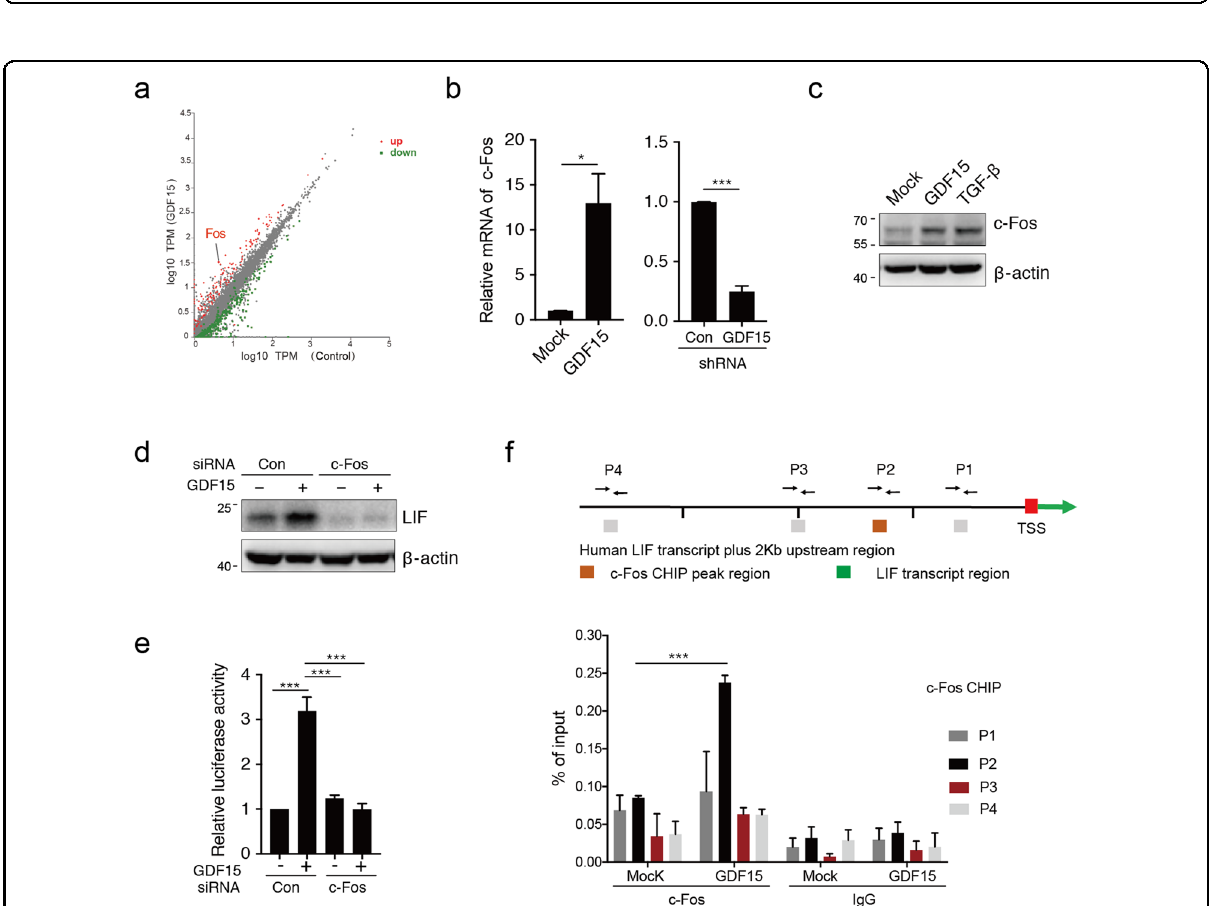
Fig. 2 GDF15 upregulates LIF transcription via c-Fos binding to the promoter. a Scatter plot showing differentially expressed genes between control and 10 ng/ml GDF15-treated U87 TS cells. b qRT-PCR analysis of c-fos gene expression in U87 TS cells treated with GDF15 or short hairpin RNA lentivirus targeting the GDF15 gene. c Immunoblotting analysis of c-Fos and β -actin expression in U87 TS cells after treatment with GDF15 and TGF- β for 5 days. d Immunoblotting analysis of LIF protein expression in U87 TS cells after treatment with GDF15 and c-Fos siRNA or control siRNA. e U87 TS cells were transfected with a luciferase construct containing the LIF promoter and treated with GDF15 and c-Fos siRNA or control siRNA for 48 h, and luciferase activity was determined using a dual-luciferase reporter assay system. f Cells were incubated without or with GDF15 and subjected to ChIP assays using c-Fos or IgG isotype control antibodies. Bar chart representing the qPCR results for the immunoprecipitated LIF promoter. Values in b , e , and f are from three independent experiments and are expressed as mean ± s.e.m. * P < 0.05, *** P < 0.0005. Unpaired t test ( b , f ); one-way ANOVA with Tukey ’ s multiple comparison test ( e